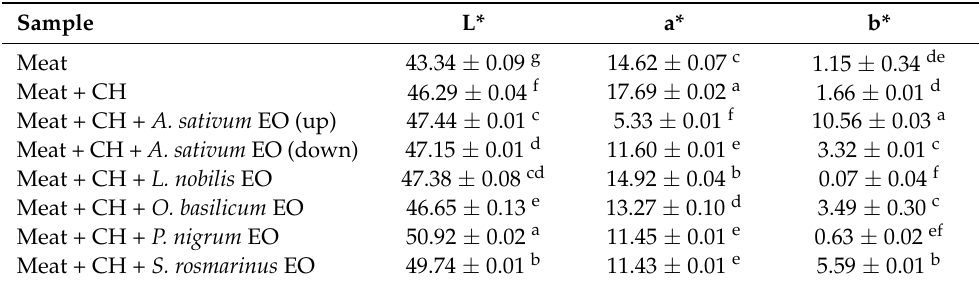
Table 3. Colour coordinates (L*, a*, b*) of beef meat samples in cubic embedding moulds. In each column, different letters (a–g) indicate statistically significant differences.